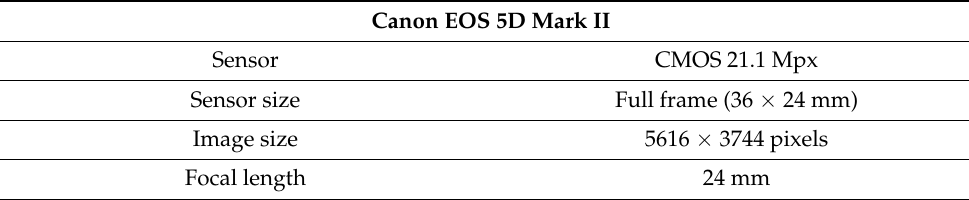
Table 3. Specifications of the DSLR camera used for the photogrammetric